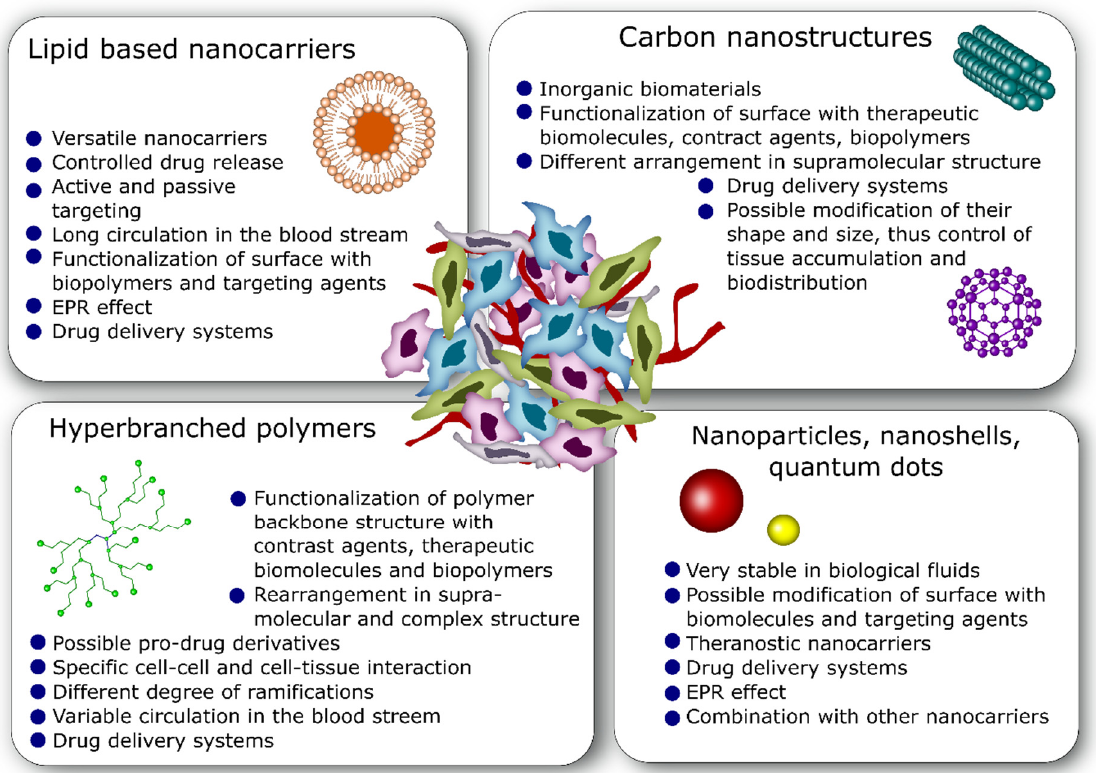
Figure 2. Properties of the types of nanocarriers discussed in this review.